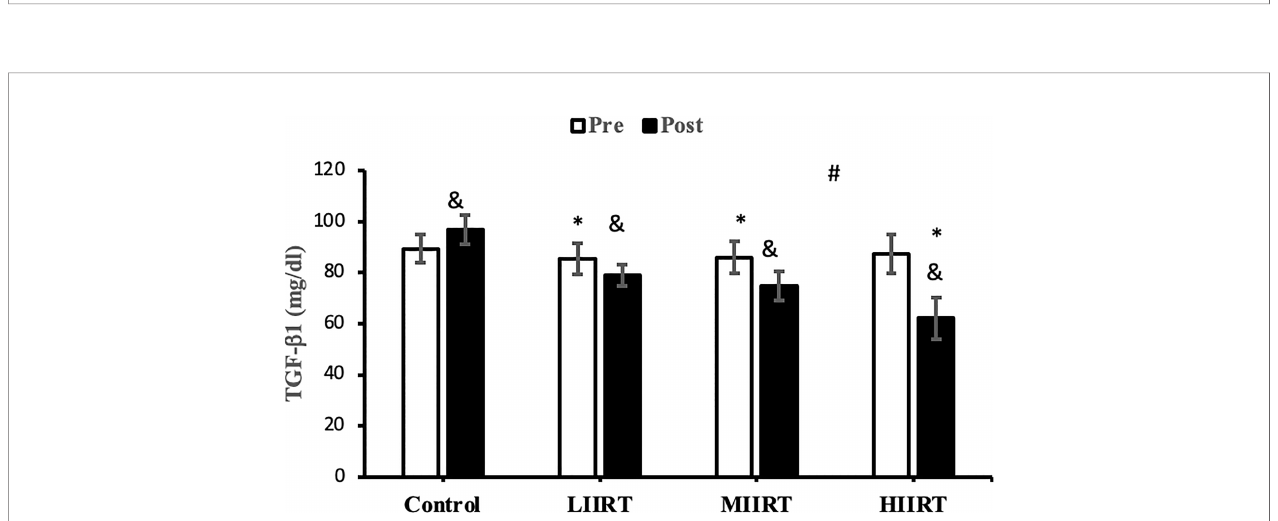
FIGURE 6 | Pre and post-training values (mean ± SD) for TGF- b 1 in control, low-intensity interval resistance training (LIIRT), moderate-intensity interval resistance training (MIIRT), high-intensity interval resistance training (HIIRT) groups. *Signi fi cant differences from the control group (p<0.05). & Signi fi cant differences from pretest values (p<0.05). # Signi fi cant differences between training